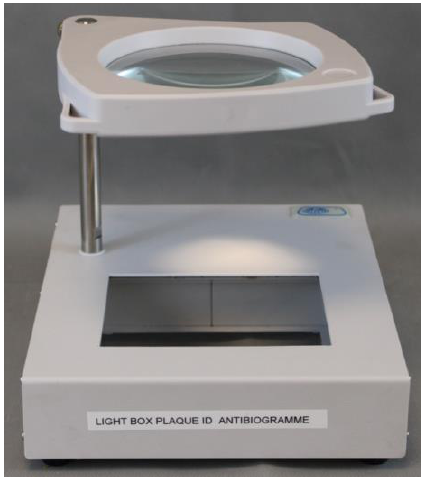
Figure 2. Prototype of the microplate viewer box by JP Selecta, used for visual reading. The background at the bottom can be changed from black to white [26].